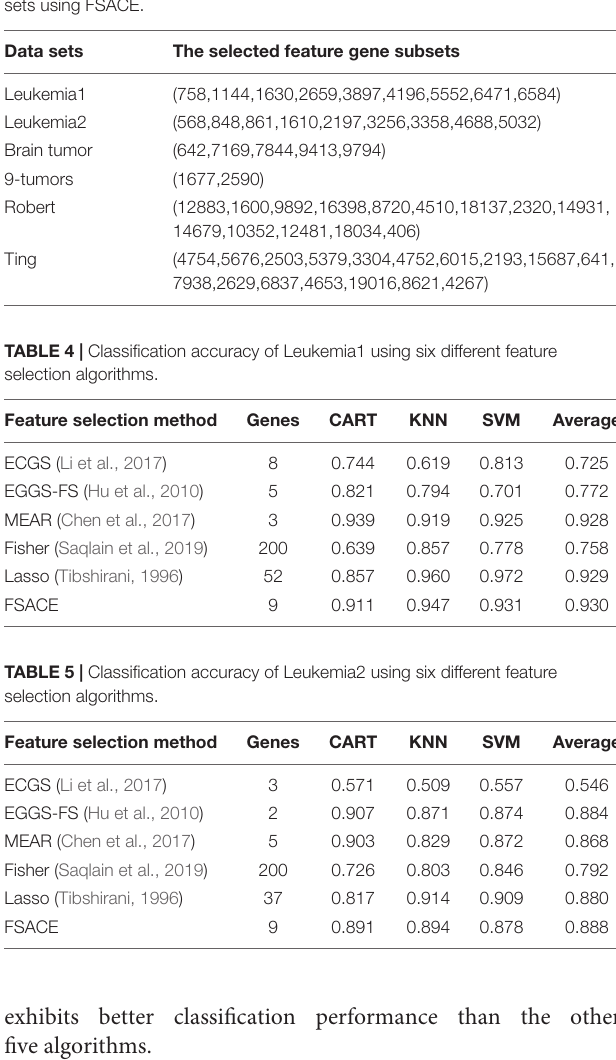
TABLE 3 | The selected feature genes on six gene expression data sets using FSACE.